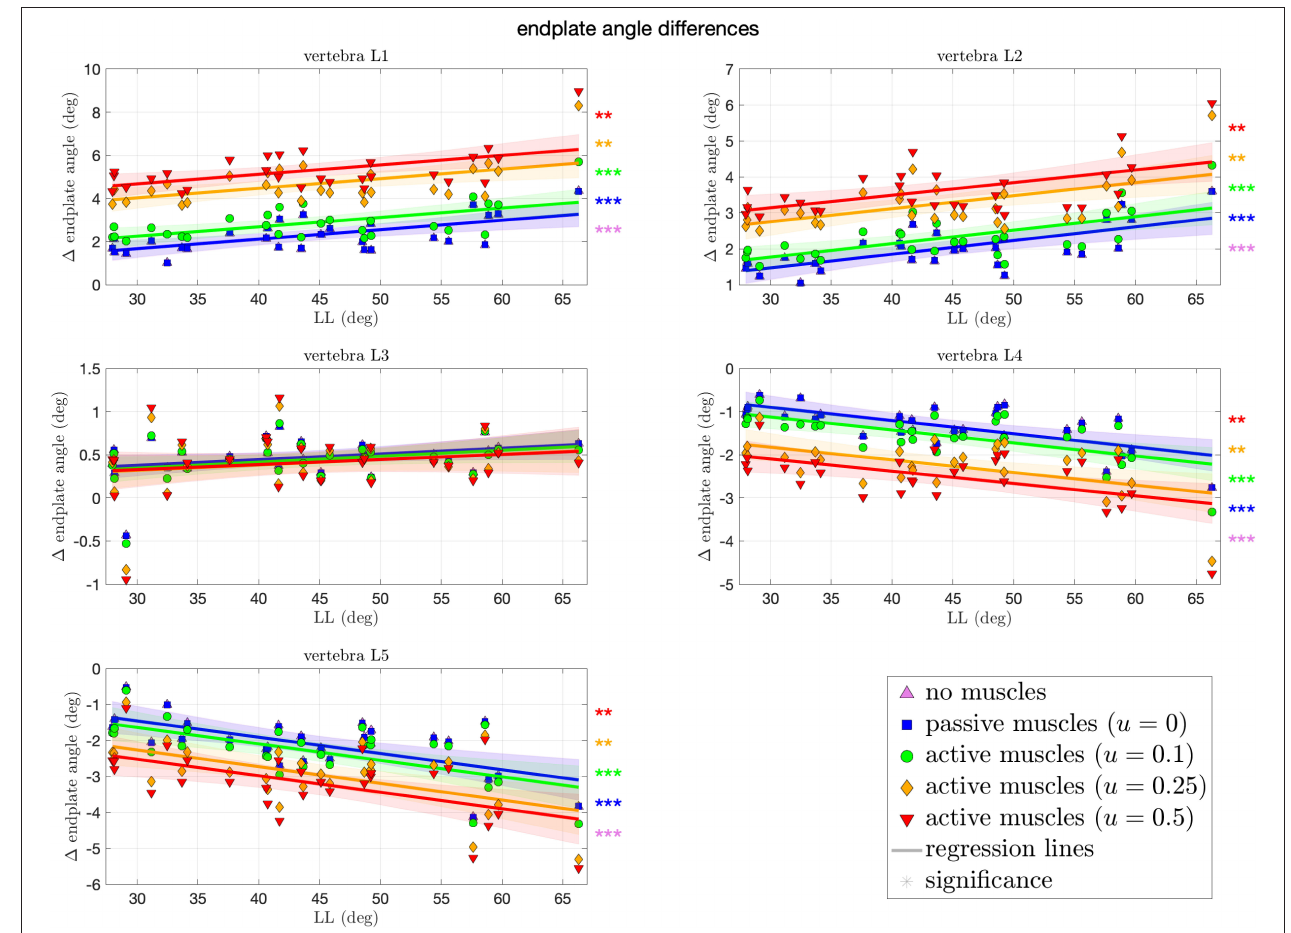
FIGURE 4 | Differences in Cobb angles during compression of all 28 vertebrae against LL. Colors and marker symbols of the data points and the corresponding regression lines consistently correspond to the modes: lilac up-pointing triangles for simulations without muscles involved; blue squares for passive muscles; as well as green circles, orange diamonds, and red down-pointing triangles for muscle stimulation of u shown as pale areas of the corresponding color. The significance of the statistical test is indicated by alongside asterisks (** highly significant with p <